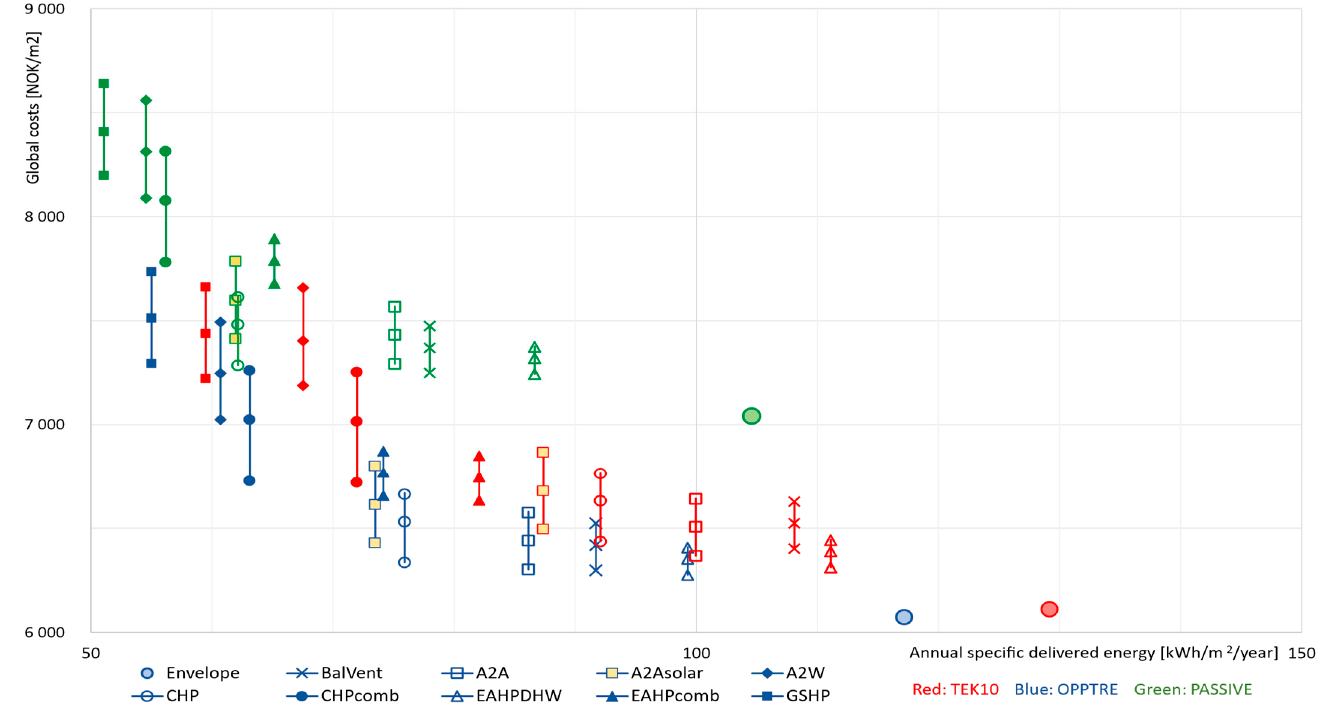
Figure 9. Specific global costs and delivered energy of the Kristiansand house with electricity price 1.0 NOK/kWh.